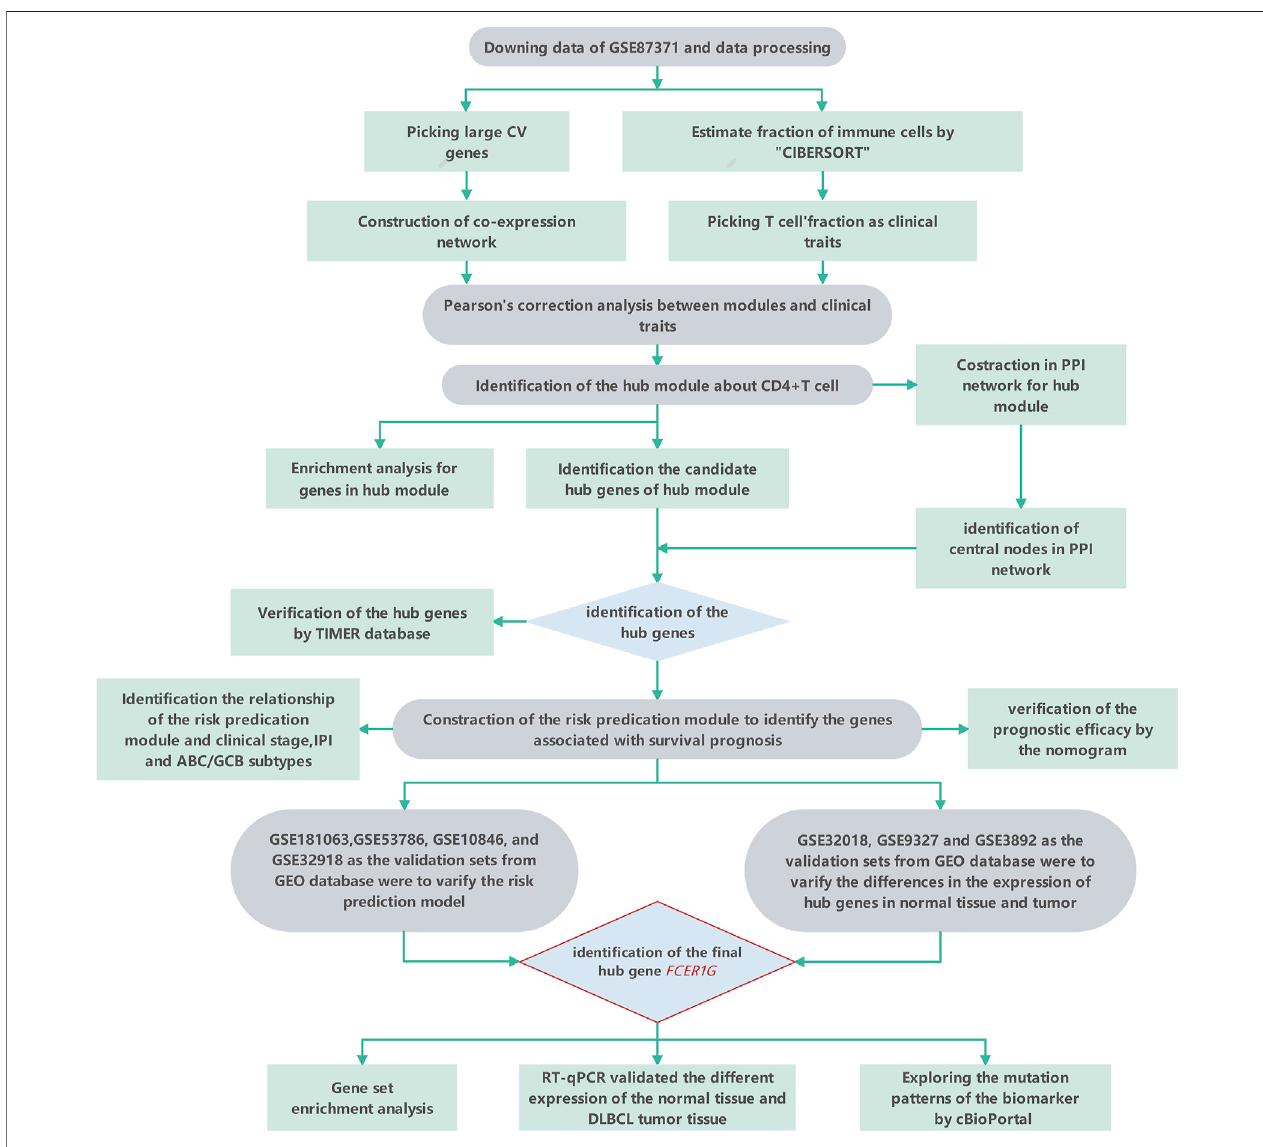
FIGURE 1 | The work fl ow of the